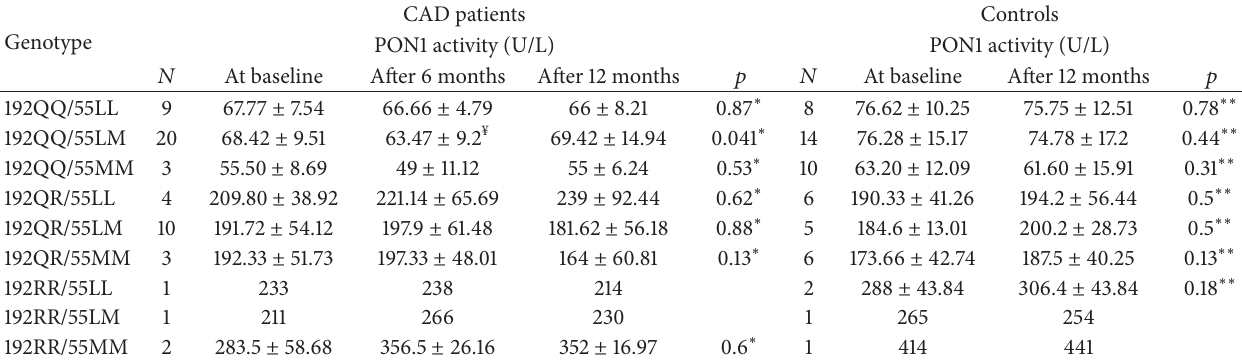
Table 5: Combined genotypes and PON1